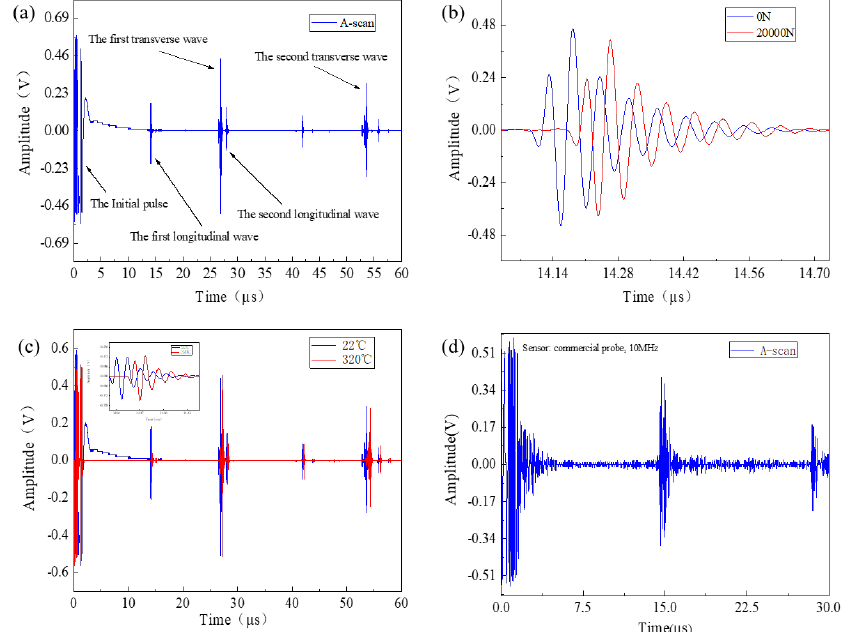
Figure 5. ( a ) The measured A − scan waveform collected from the high − frequency, piezoelectric thin − film sensor, ( b ) comparing TOF change of the pulse echo before and after applying tension at 20 kN, ( c ) A − scan waveforms of the smart bolt at 22 °C and 320 °C (the insert compares the waveform of the first longitudinal wave for the bolt at 22 °C and 320 °C), ( d ) the measured A − scan waveform collected from the commercial piezoelectric probe.